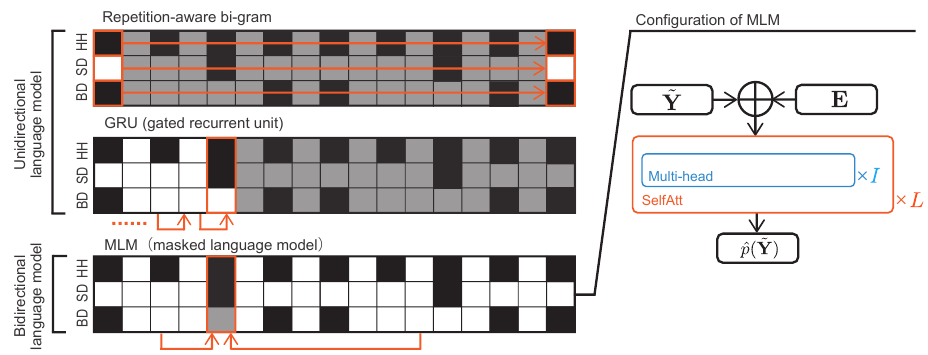
Figure 4. Language models used for regularized training of a transcription